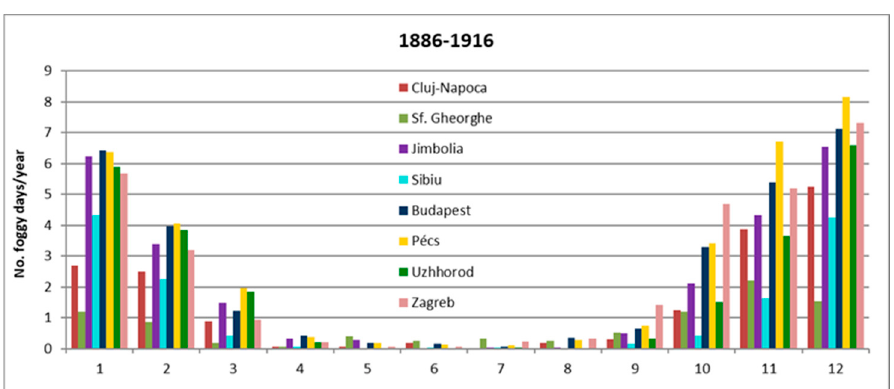
Figure 3. The monthly distribution of fog events over the Carpathian Basin.